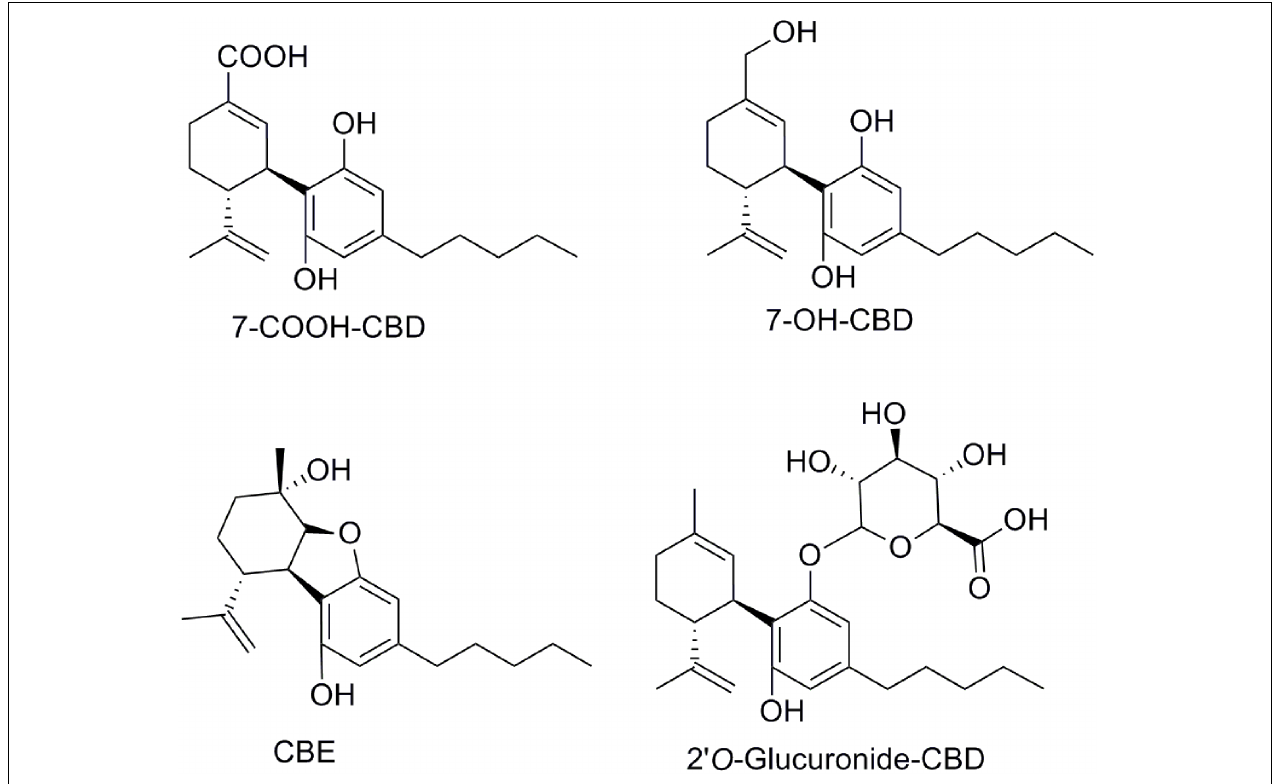
FIGURE 4 | Selected metabolites of